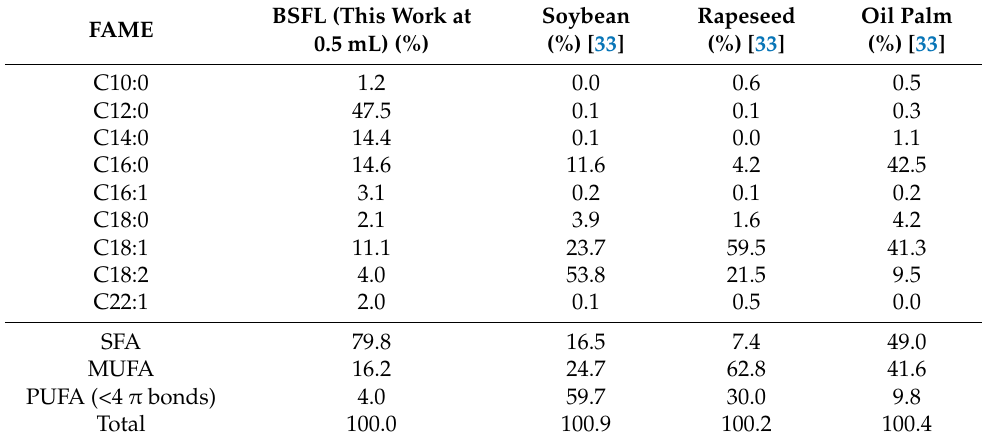
Figure 5. FAME profiles derived from black soldier fly larvae fed with palm kernel expeller containing various inoculation volumes of R. oligosporus . Table 1. FAME compositions in biodiesel derived from well-established feedstock.